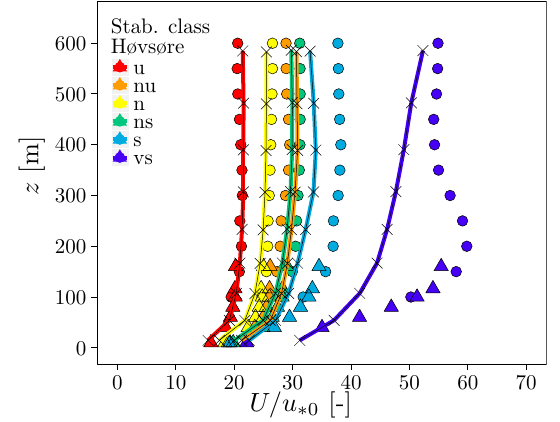
Figure 7. As Fig. 6, except that u ∗ 0 is taken from the